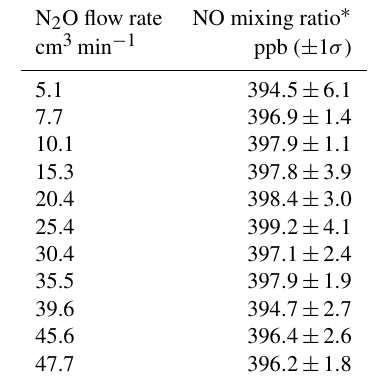
Table 1. NO mixing ratios measured from a Model 714 NO 2 / NO / O 3 Calibration Source as a function of the N 2 O flow